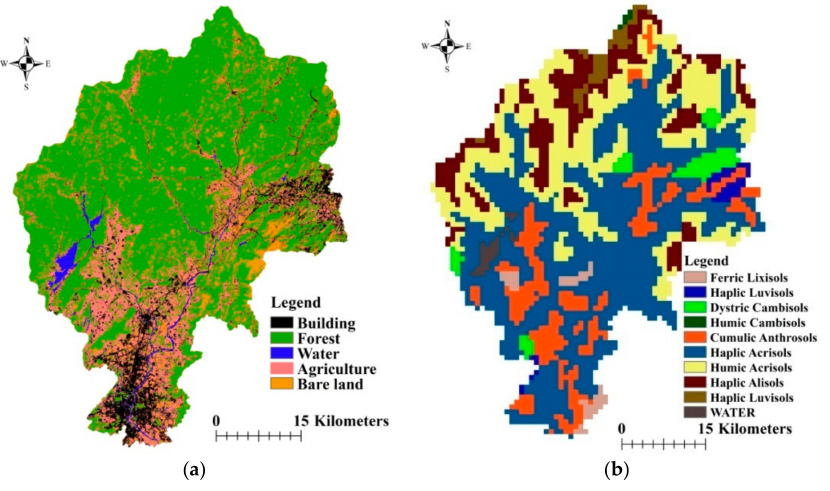
Figure 2. ( a ) Land use data; ( b ) Soil